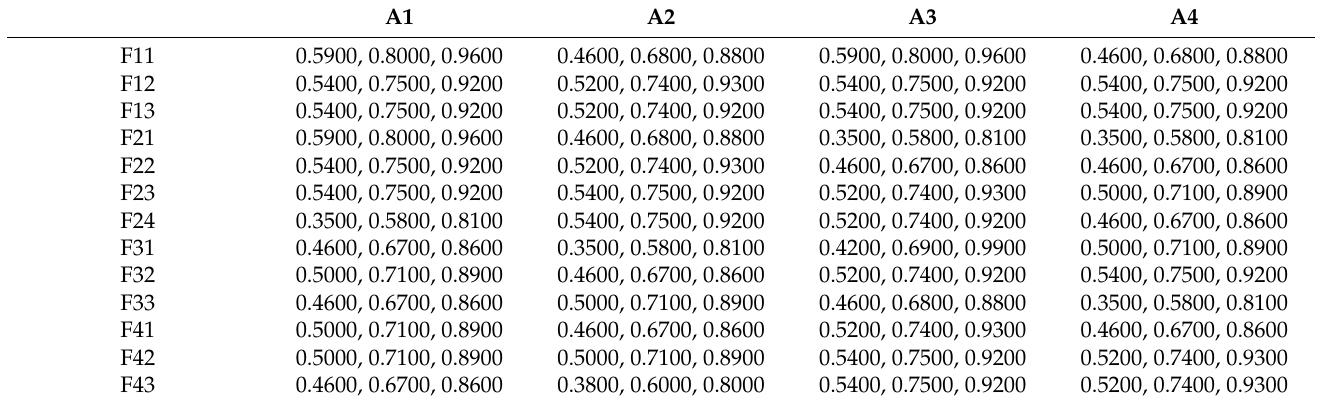
Table 4. Normalized fuzzy decision matrix.